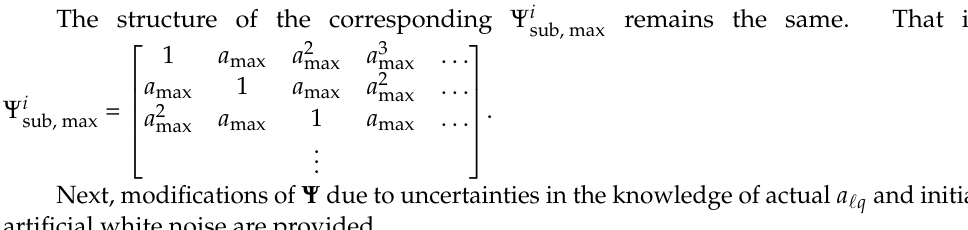
remains the sub, max